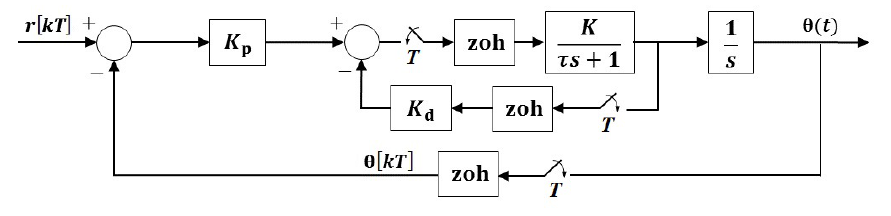
Figure 3. Sampled-data block diagram of the closed-loop motor control system.